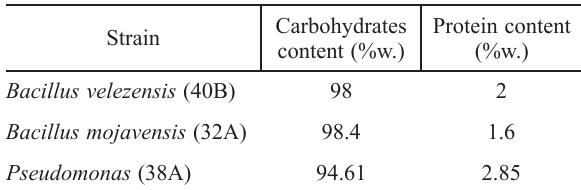
Table 1 – Composition analysis of purified biopolymers Strain